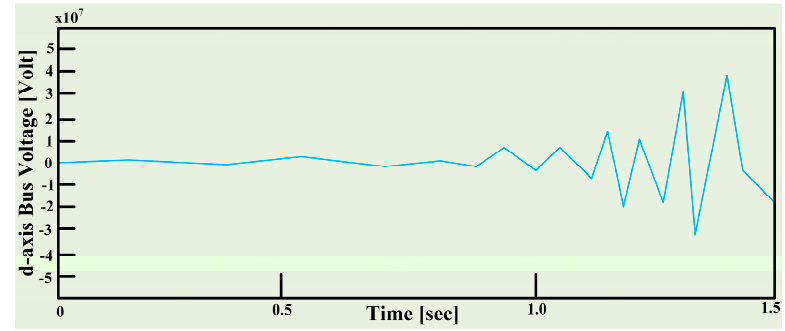
Figure 4. d-axis bus voltage instability due to CPL.